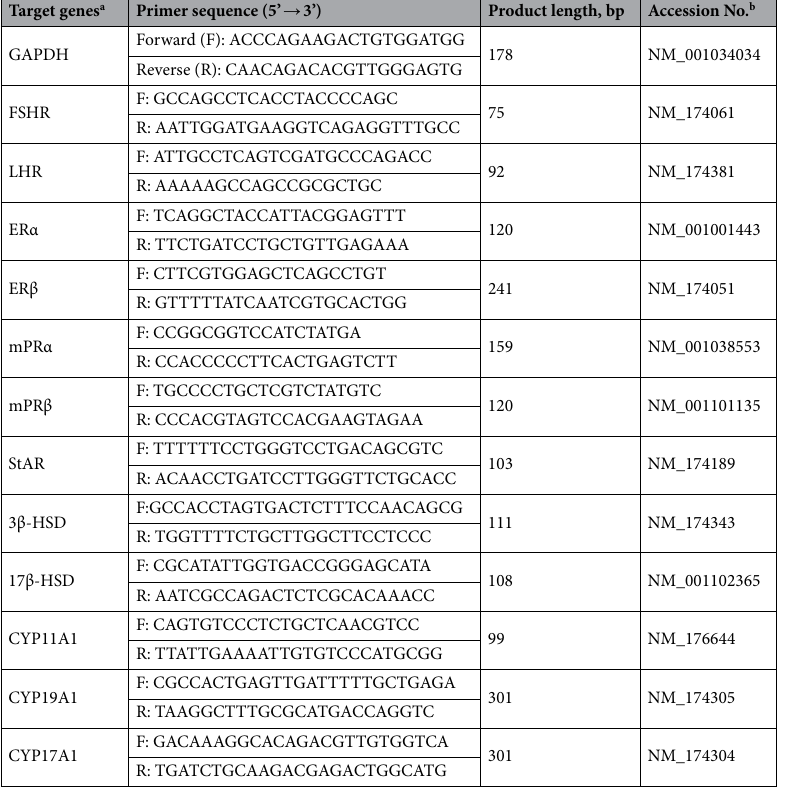
Western blot analysis. To detect the key protein (17β-HSD, FSHR, LHR, StAR, ERα, ERβ, CYP17A1, p - AKT, AKT, p -mTOR, mTOR, p -PI3K, and PI3K) involved in gonadal hormones regulation, western blot was per- formed. Firstly, total protein was extracted using RIPA solution (Cell Signaling Technology, Inc., Danvers, MA), with the protease inhibitor cocktail (Roche, Penz-berg, Germany) and phosphatase inhibitor cocktail (Roche, Penz-berg, Germany) as described previously 11 . The protein concentration was determined using an enhanced BCA assay kit (Beyotime Biotechnology, Shanghai, China). Secondly, 30 μg protein samples were mixed with 5× loading buffer, denatured (100 °C, 5 min), and separated by 10% sodium dodecyl sulfate–polyacrylamide gel electrophoresis (SDS-PAGE) at 100 V for 30 min, followed by 120 V for about 1.5 h. The isolated protein was transferred into Polyvinylidene Fluoride membranes (Immobilon-FL membrane, Millipore, Danvers, MA) with for 2 h. Then, membranes were washed and incubated at 4 °C overnight with the specific primary antibodies (Table 2). After several washes in TBST, membranes were incubated with corresponding secondary antibodies (Table 2) for 2 h at room temperature. Finally, the blot was washed 3 times for 10 min with wash buffer, and bands were detected by enhanced chemiluminescence (ECL) using Luminata Classico Western HRP Substrate (WBLUC0100, Millipore, Danvers, MA).The ECL signals were recorded using an imaging system (Bio-Rad, California, USA) and quantified using Quantity One software (Bio-Rad, USA) normalized to GAPDH. In the bar graph, each column represents an average of four or five cows per group. A representative set of blots from six cows was shown here. Histological examination. Ovaries (n = 3 per group) were fixed in 10% buffered formalin, processed rou- tinely through ascending alcohols and xylene, embedded in paraffin, serially sectioned at 5 µm, and stained with hematoxylin and eosin (HE) 39 . Follicle classification as primordial or growing was performed on HE-stained sections under an Eclipse TE2000U inverted microscope with a twin CCD camera (Nikon, Tokyo, Japan). Three sections of each tissue for each cow were detected 40 . In brief, to avoid counting a follicle twice, only follicles with a visible oocyte nucleus were counted. A primordial follicle was defined as an oocyte surrounded by a single layer of flattened pre-granulosa cells. Growth follicles include follicles at all stages of development. No atretic follicles were examined in this study. Two experimenters counted the number of follicles in each category without know- ing the groups. Finally, the percentage of the number of follicles (primordial or growing) on the total number of oocytes was calculated.